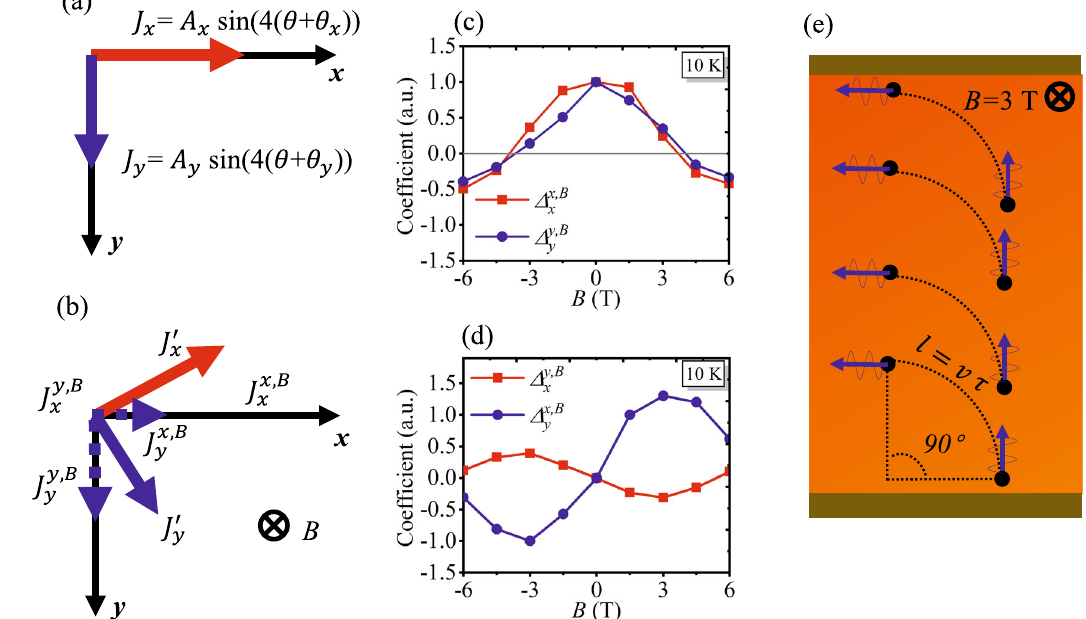
Fig. 3 Macroscopic and microscopic analysis. Schematic illustrations of bulk photovoltaic (BPV) effect a without the magnetic fi eld and b under the magnetic fi eld B in the out-of-plane direction. J x and J y are the original photocurrents along the x and y directions, respectively. J forced-induced photocurrent of J x and J y , respectively. J x ; B x and J y ; B x are the photocurrents projected from J the photocurrents projected from J fi eld-dependent projection coef fi cients of 4 x ; B acting on electrons under a 3 T magnetic fi eld. The direction of the electron ’ s motion is indicated by the blue arrow; the black dashed line indicates the trajectory of the motion of electrons. The error bars in the plots represent the standard error. The error bars are obtained from the standard deviation of the least-squares fi t parameters and are smaller than the